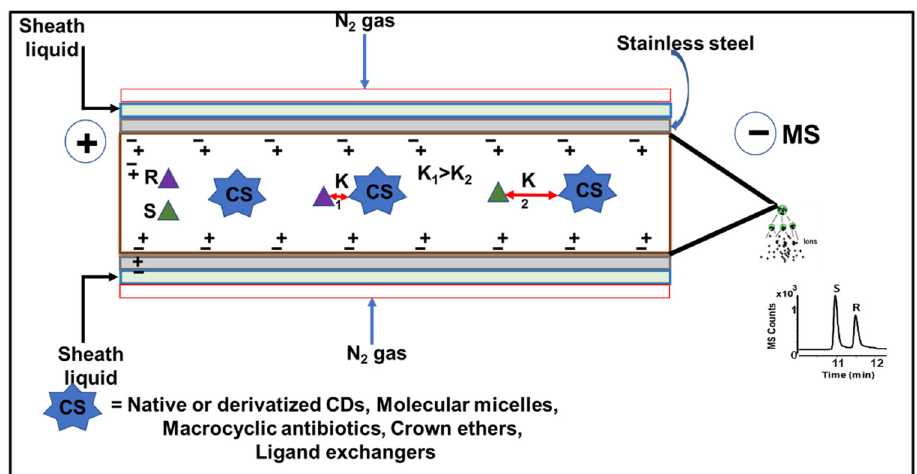
Figure 2. Schematics of chiral CE-MS under positive polarity. The chiral selector can be native cyclodextrins (CDs), derivatized CDs, macrocyclic antibiotics, crown ethers, ligand exchangers, and anionic molecular micelles (MoMs).